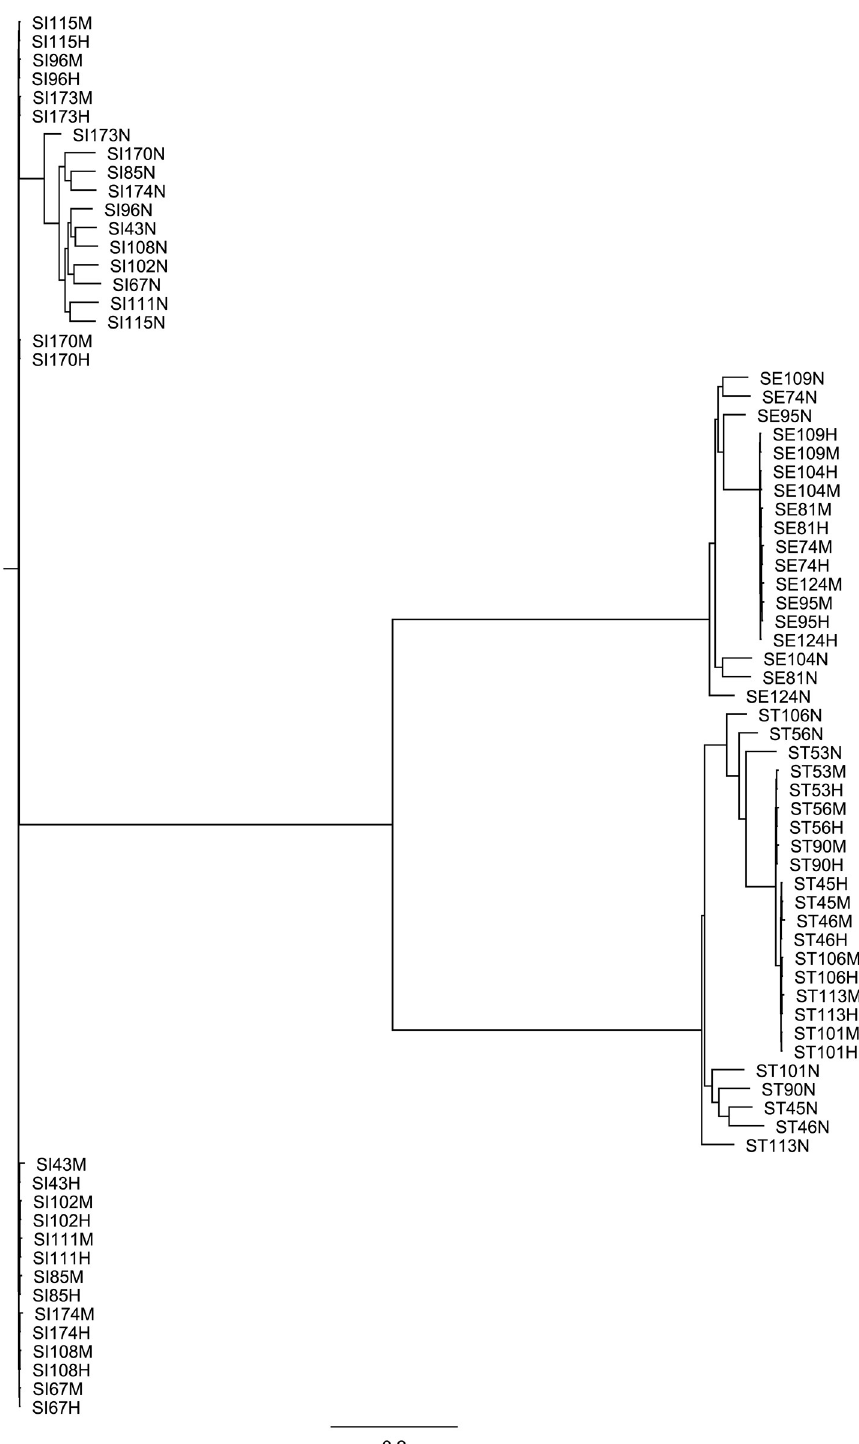
Fig 3. Whole-genome phylogenetic trees of Salmonella isolates based on their hybrid (H), MinION (N), and MiSeq (M) assemblies.